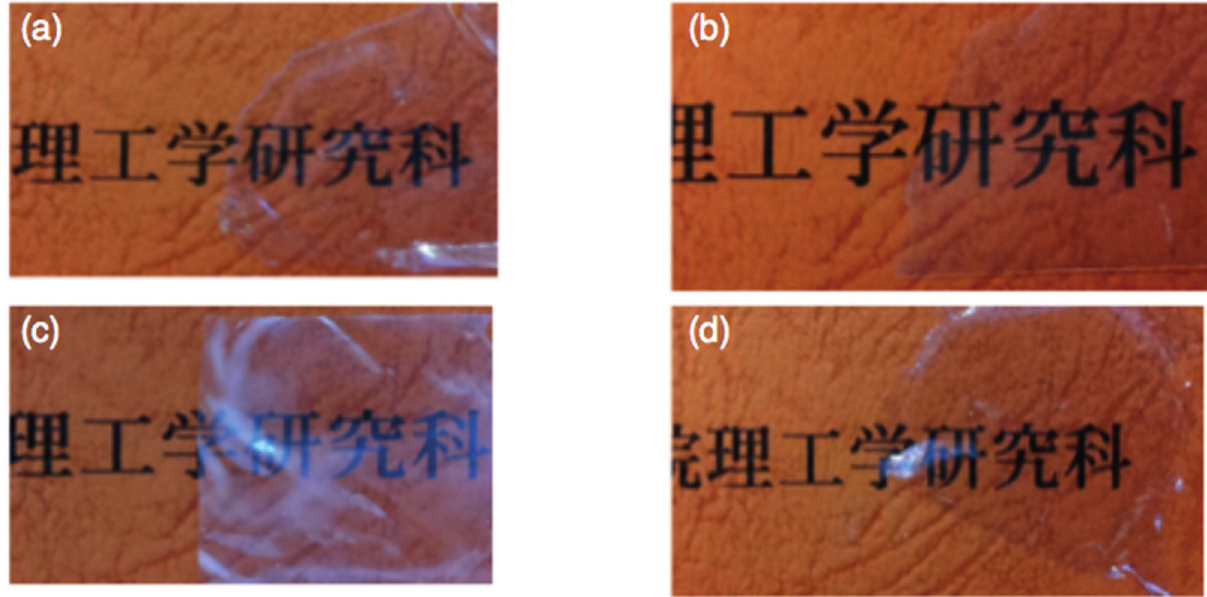
Figure 3. Photo images of composite films of the zinc hybrid polymers with common polymers, ( a ) TZn/PMMA; ( b ) TZn/PS; ( c ) BZn/PMMA; and ( d ) BZn/PS. Table 3. Thermal behaviors of the zinc hybrid polymers and their composite films with common polymers. BZn BZn 10 /PS 90 BZn 10 /PMMA 90 TZn TZn 10 /PS 90 TZn 10 /PMMA 90 PS PMMA 272 161 170 113 139 380 281 40 86 100